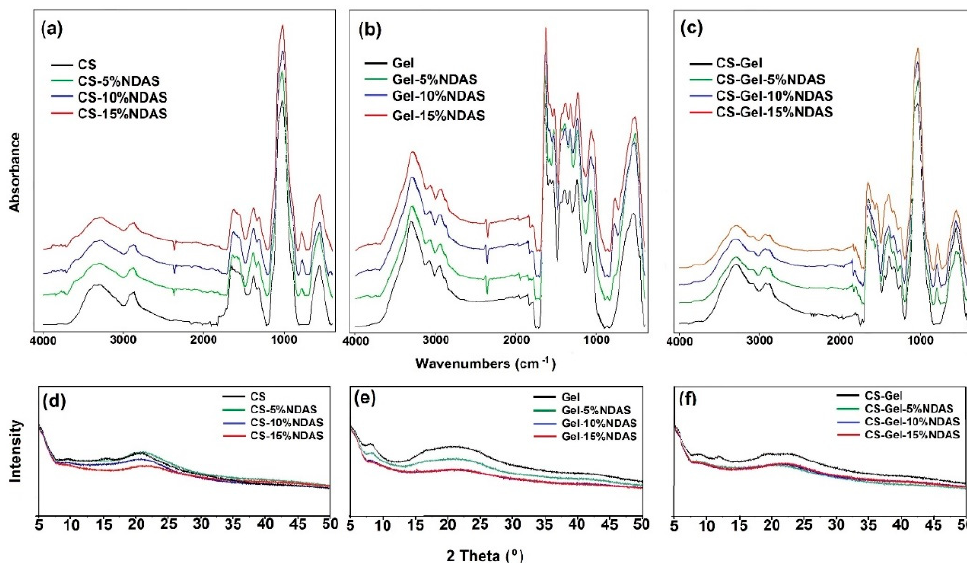
Figure 5. ATR-FTIR spectra of ( a ) chitosan, ( b ) gelatin, and ( c ) chitosan–gelatin films cross-linked by dialdehyde starch nanocrystals and the X-ray diffraction (XRD) patterns of ( d ) chitosan, ( e ) gelatin, and ( f ) chitosan–gelatin films cross-linked with dialdehyde starch nanocrystals.